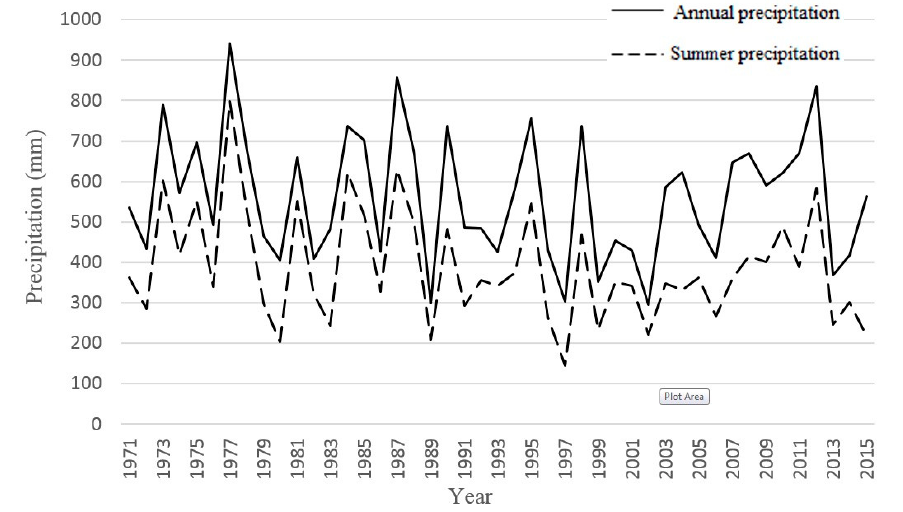
Figure 9. The annual precipitation and summer precipitation in the study area.